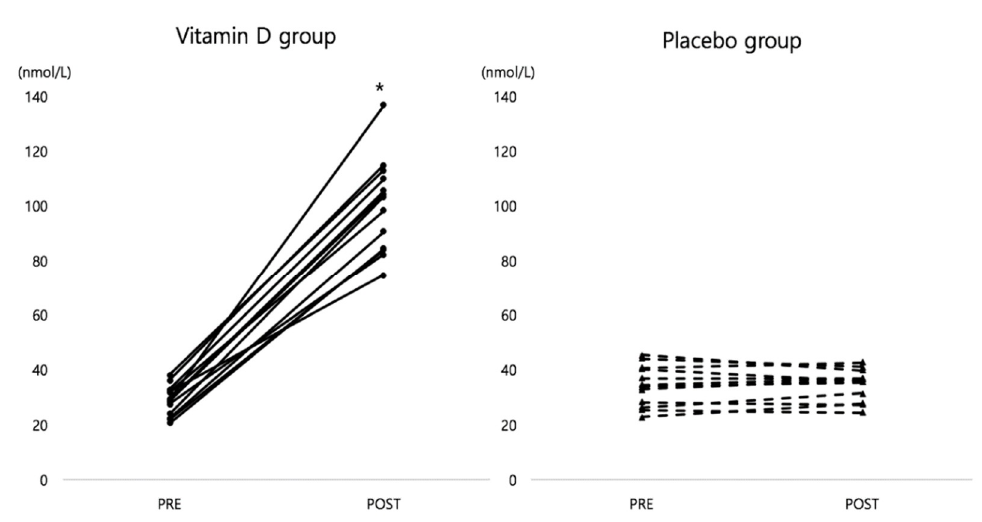
Figure 2. Individual changes of serum 25(OH)D concentration from pre- to post-tests. * p < 0.05 indicates a significant increase from pre- to post-tests in the vitamin D group.